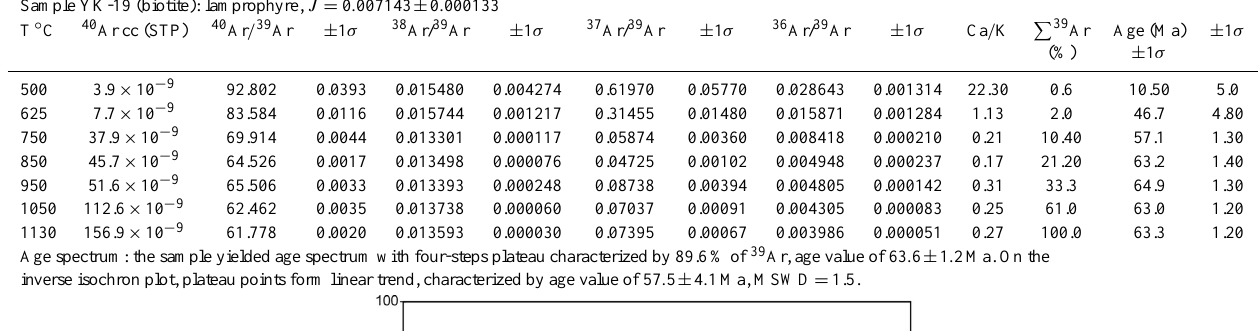
Table 4b. 40 Ar / 39 Ar biotite age data for a lamprophyre dike (Sample No. YK-19) from the island arc unit in the Ankara Mélange, Turkey. Sample YK-19 (biotite): lamprophyre, J = 0 . 007143 ± 0 . 000133